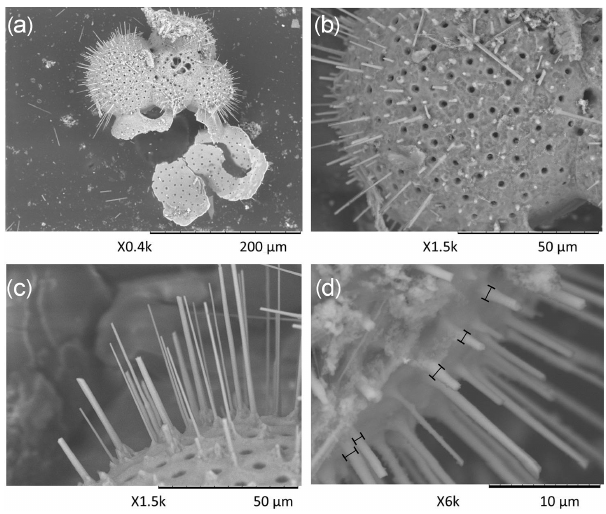
Figure 2. Example of SEM-images of the foraminiferal specimens studied here: (a) example of a laser-ablated T. sacculifer specimen, (b) spine count area in the F-2 chamber, (c) close-up of spines, showing the tapering shape of spines and (d) spine width measure- ments at the base of the